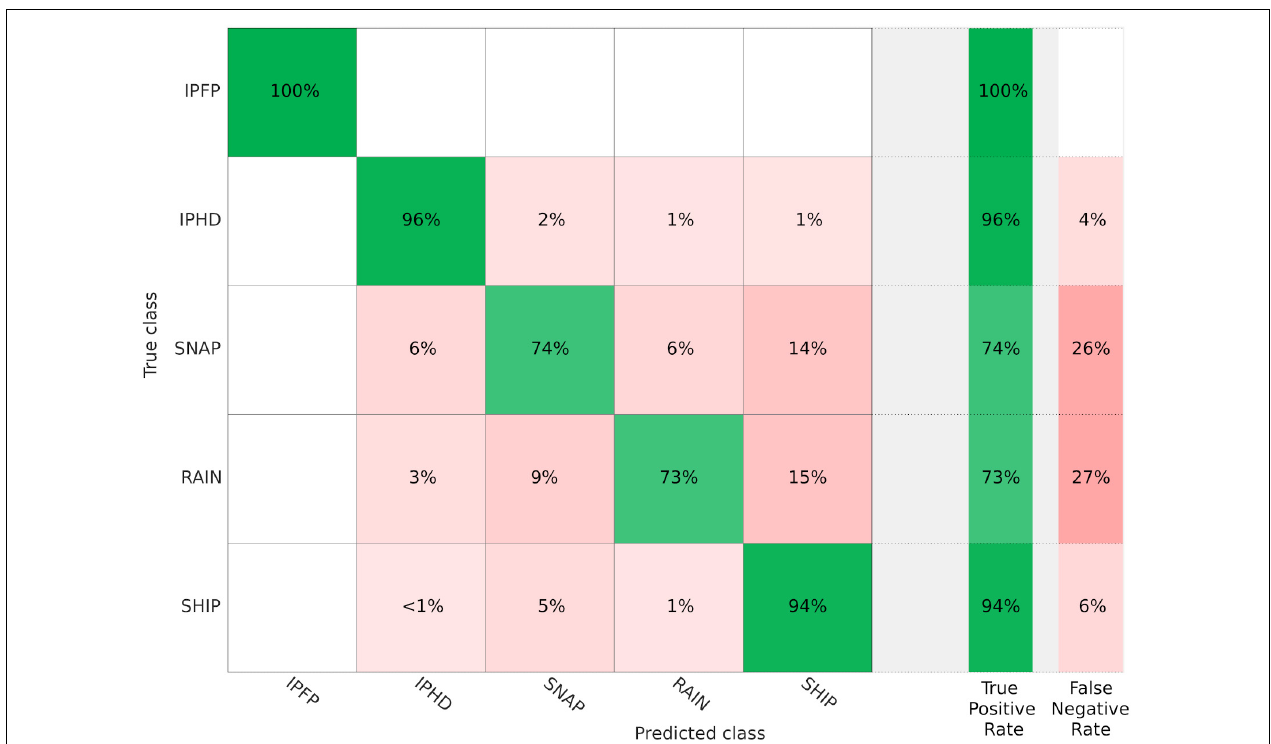
FIGURE 6 | Confusion matrix. The confusion matrix was used to visualize the performance of the trained classifier (Cubic SVM) among the five classes (IPFP, IPHD, SNAP, RAIN, SHIP). The rows show the true class and the columns show the predicted class. Each cell shows how the classifier performed per class, and true positive (TP) rate and false negative (TP) rate are reported. Cross-validation was used, so the confusion matrix was calculated using the predictions on the held-out observations. The diagonal cells show where the true class and predicted class matched. If these cells are green, the classifier has worked well. On the right, a summary of TP rate and FN rate for each